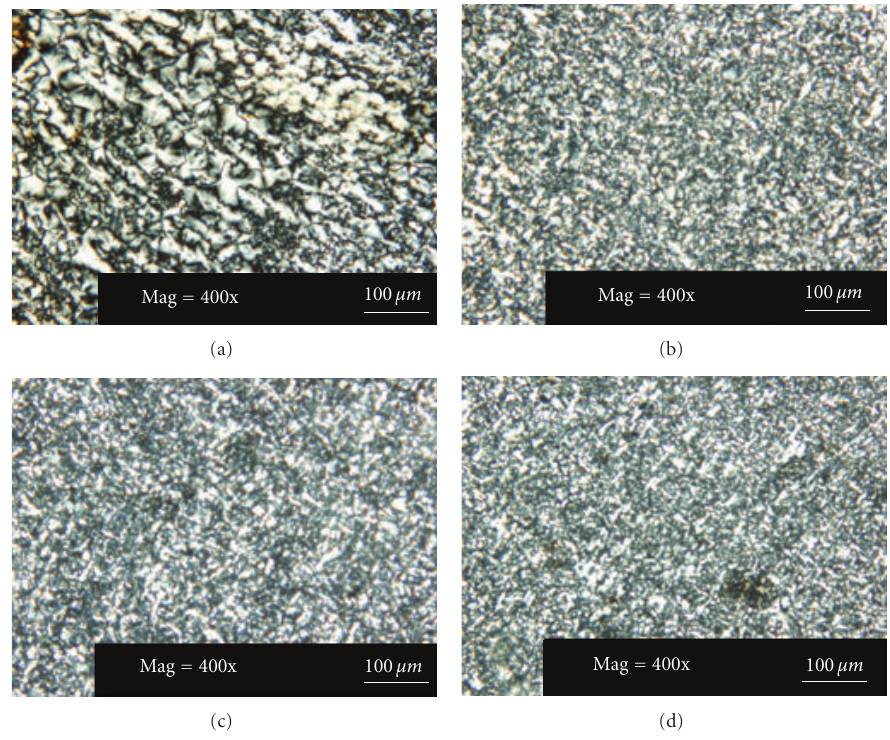
Figure 11: Polarized light micrographs of (a) CN6F, (b) N6CF2, (c) N6CF5, and (d) N6CF10.